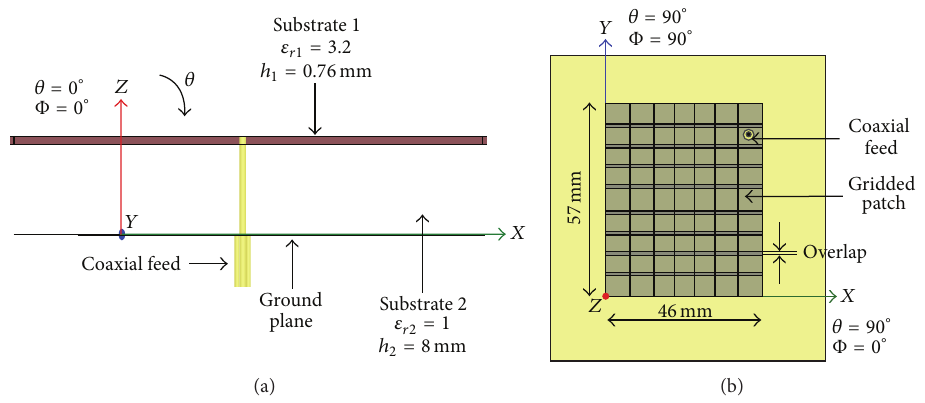
Figure 1: Antenna configuration. (a) Lateral view of the antenna. (b) Patch fragmented into 63 cells.